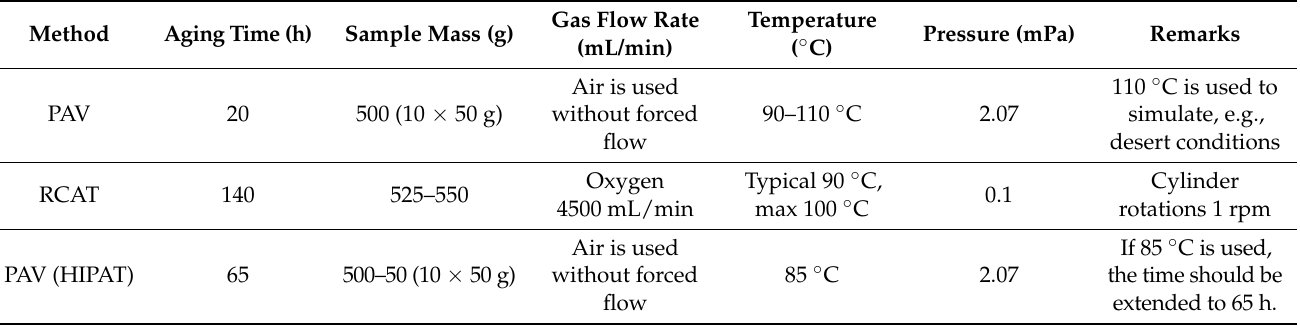
Table 3. Long-term aging conditions for basic methods standardized in EN, AASHTO and ASTM